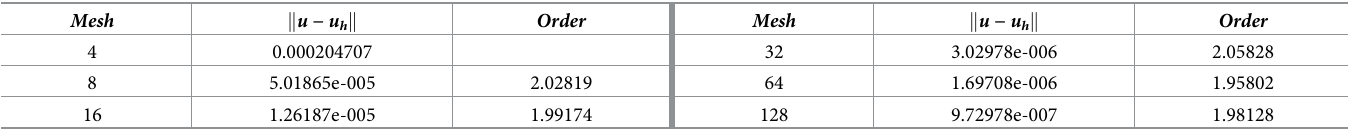
Table 1. Error profile and convergence rate for the Experiment 1. Mesh